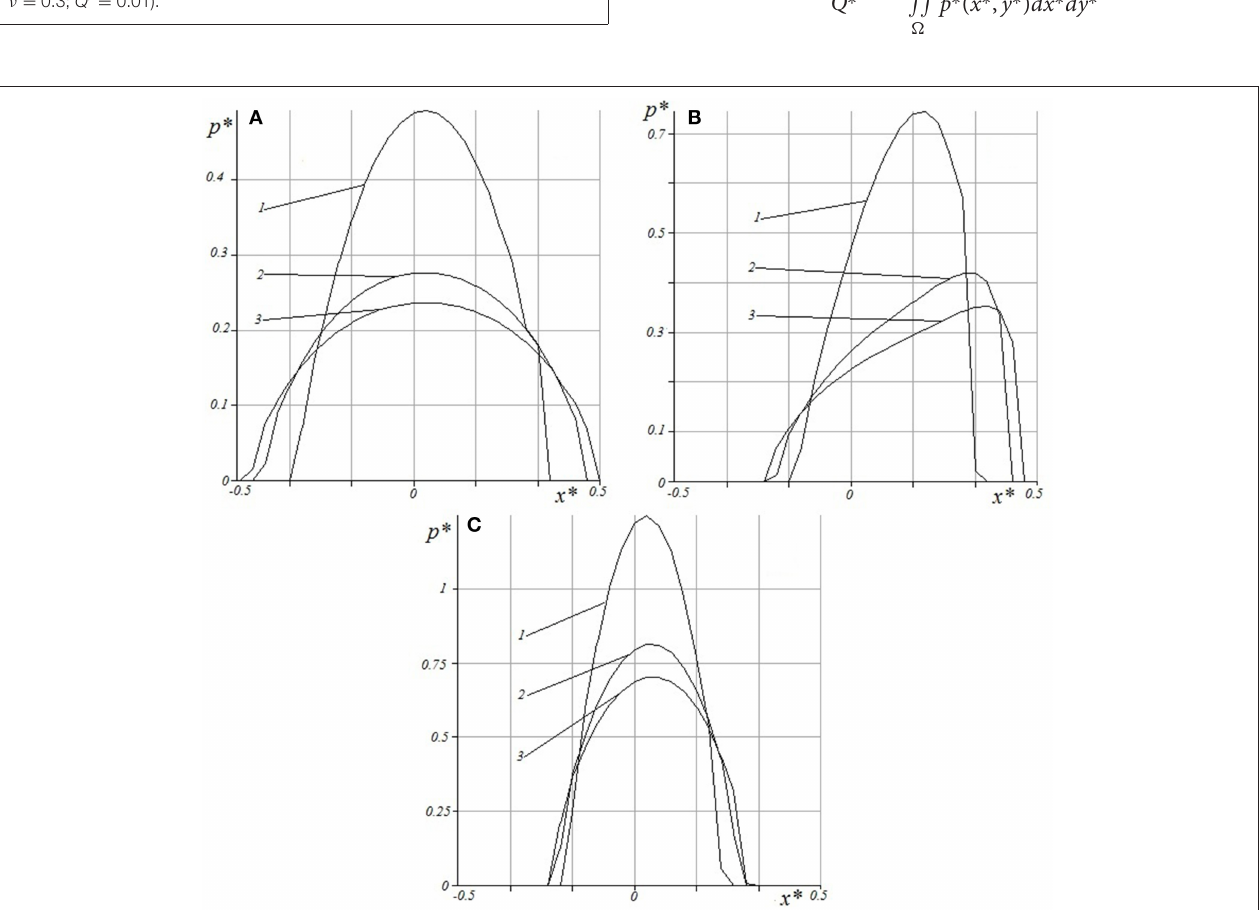
FIGURE 7 | Contact pressure distribution for different velocities and Poisson ratio: V ∗ = 1 / 60 (A) , V ∗ = 0.3 (B) , V ∗ = 10 (C) , ν = 0.45;0.3;0.2 (curves 1-3 respectively), c = 5, h ∗ = 0.1, Q ∗ = 0.1.